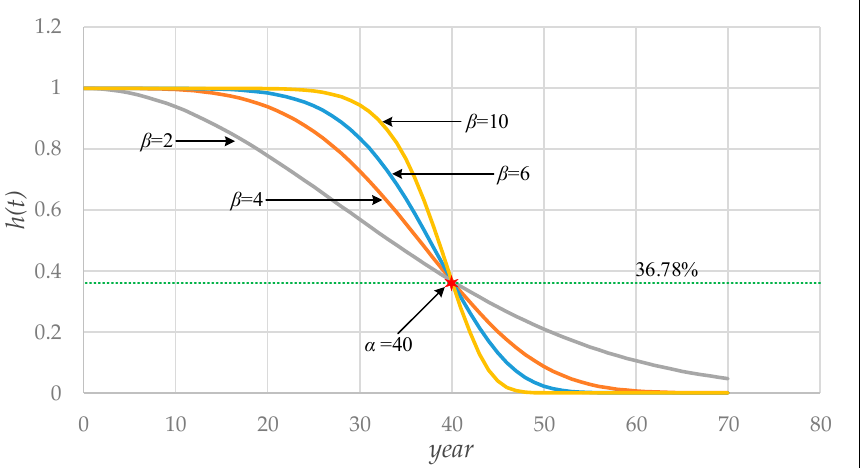
Figure 5. Weibull survival curve with different shape parameters to represent the difference in degradation behavior of underground cable system. Table 3. Correlation between shape parameter and conditional factor.